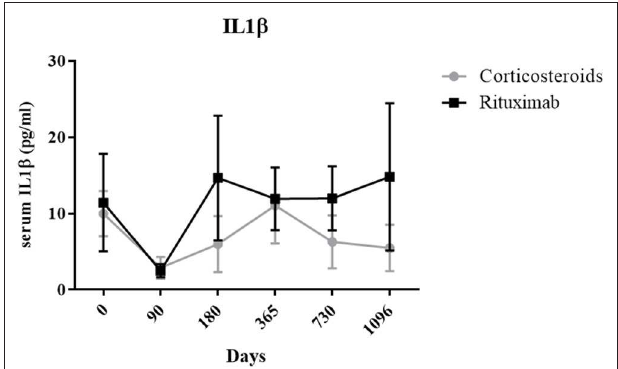
FIGURE 8 | Longitudinal analysis of mean serum IL-1 β level in rituximab (black) and corticosteroids-treated (gray) patients. Means ± standard error of the mean were compared with baseline level in each group (RTX and CS) using one-way analysis of variance followed by Bonferroni post-hoc